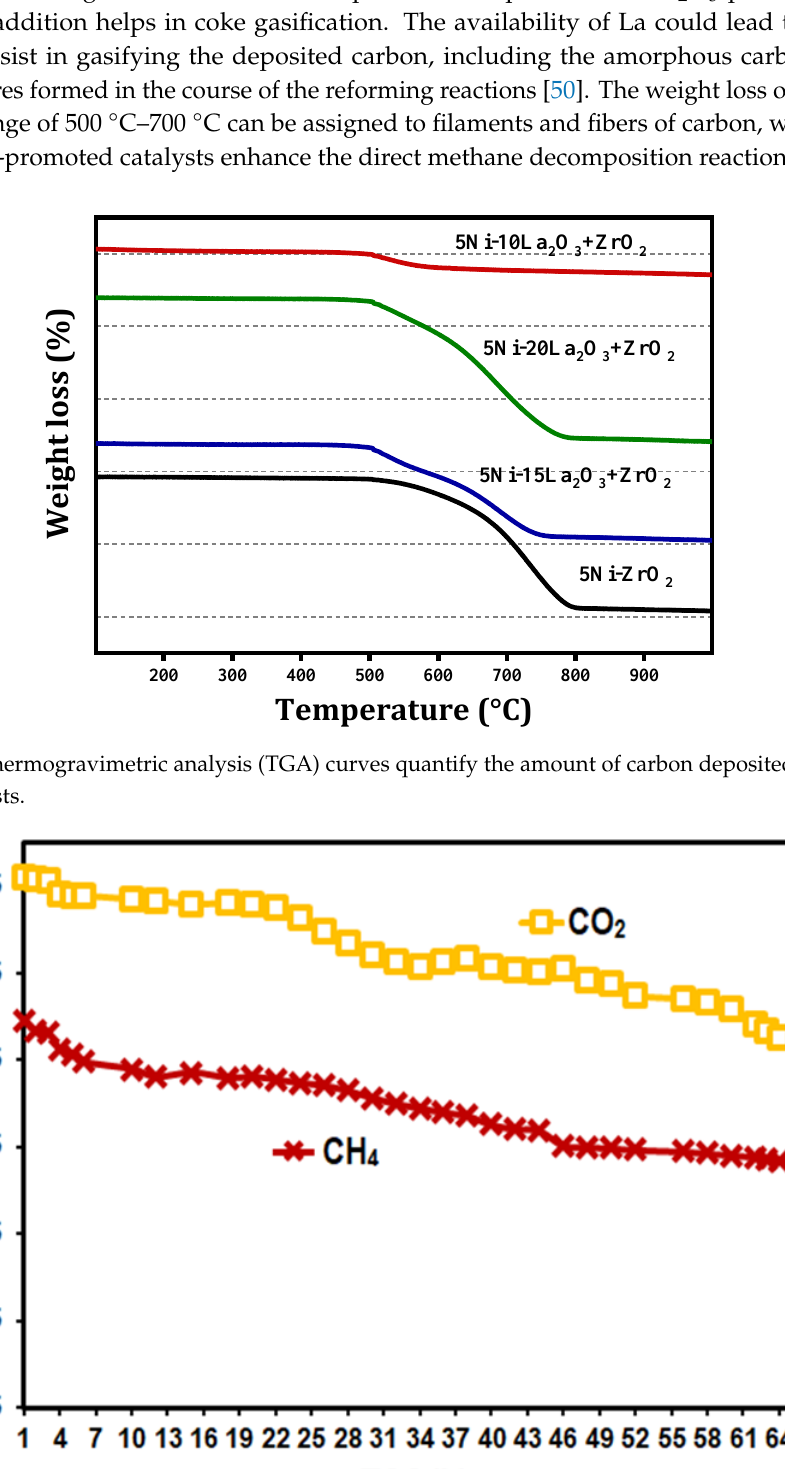
Figure 10. The stability test for 5Ni-10 La 2 O 3 -ZrO 2 for 67 h at 1 atm, 700 °C, and GHSV = 42 l/(h.g cat .).